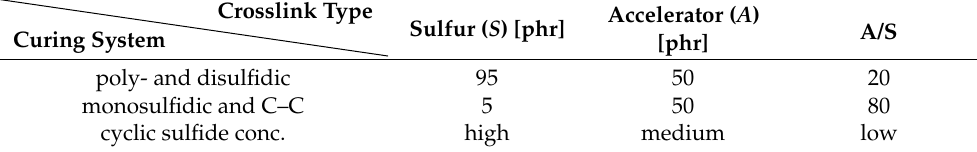
Table 3. Components used in CV, semi-EV, and EV vulcanization systems